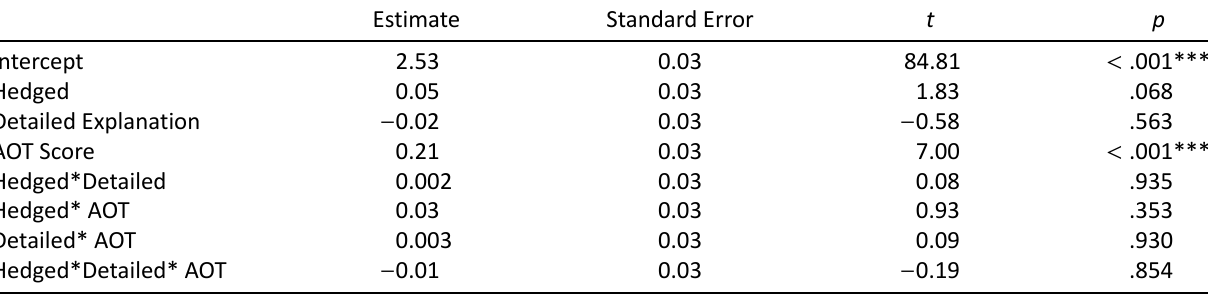
Table 6. General linear model predicting acceptance of information from correction style conditions and AOT as potential